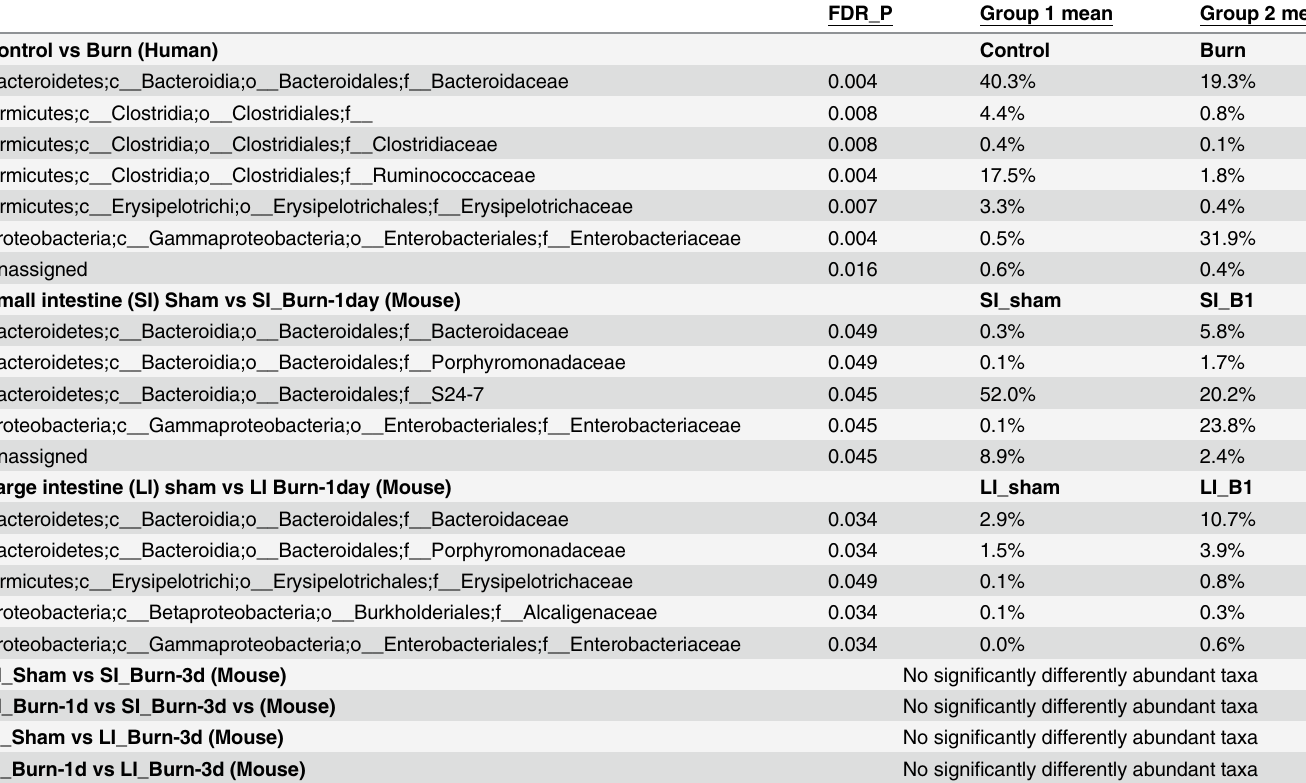
Table 1. Significant Effects of Burn Injury on Gut Microbial Community